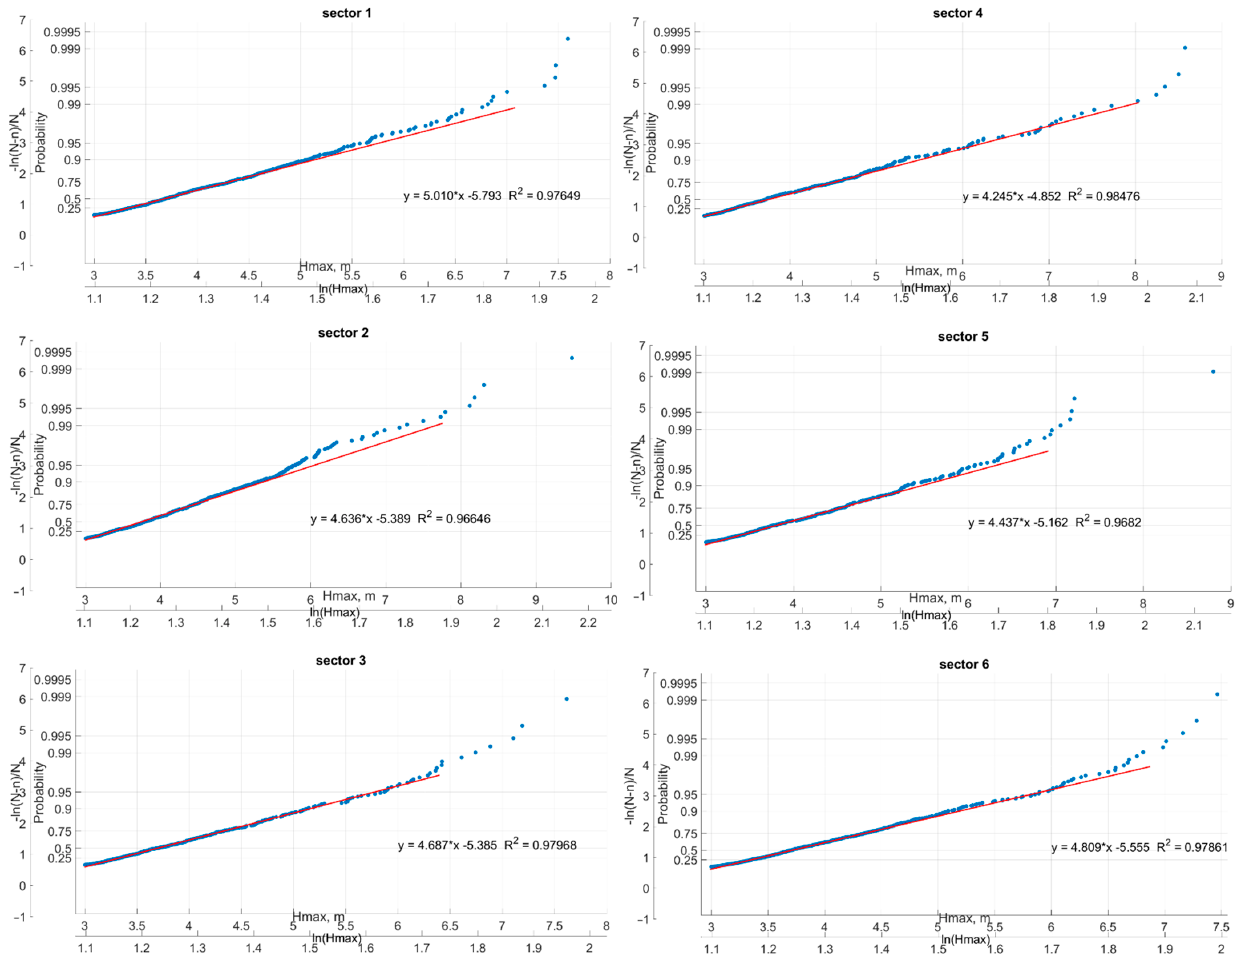
Figure 14. The empirical probability distribution of storms with different wave heights for each of the six sectors, presented in the Ppareto logarithmic coordinates. The determination coefficient of determination and regression equations are given for each sector.